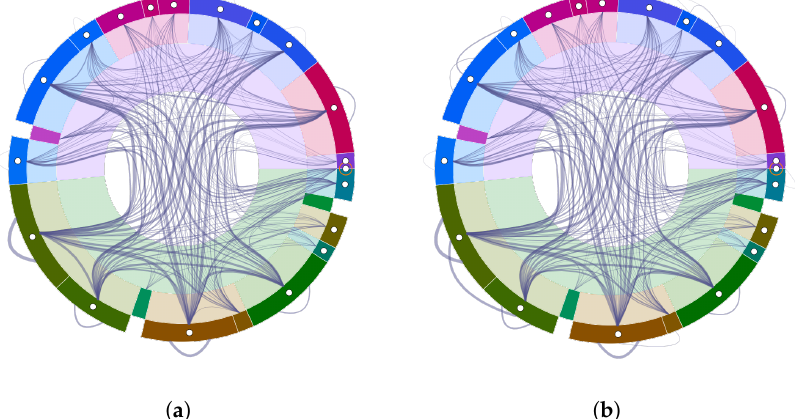
Figure 10. ( a ) Self connections trajectory runs on the outer side of the diagram to reduce overlapping among connections and improve discernibility. In this case, the same sector acts as the origin and the destination of the self-connection. ( b ) Connections among siblings can optionally be depicted on the outside of the sunburst to improve the perception of the relationships within a parent node. Note that these arcs run between the two connected sectors, unlike self-connections, which start and end in the same